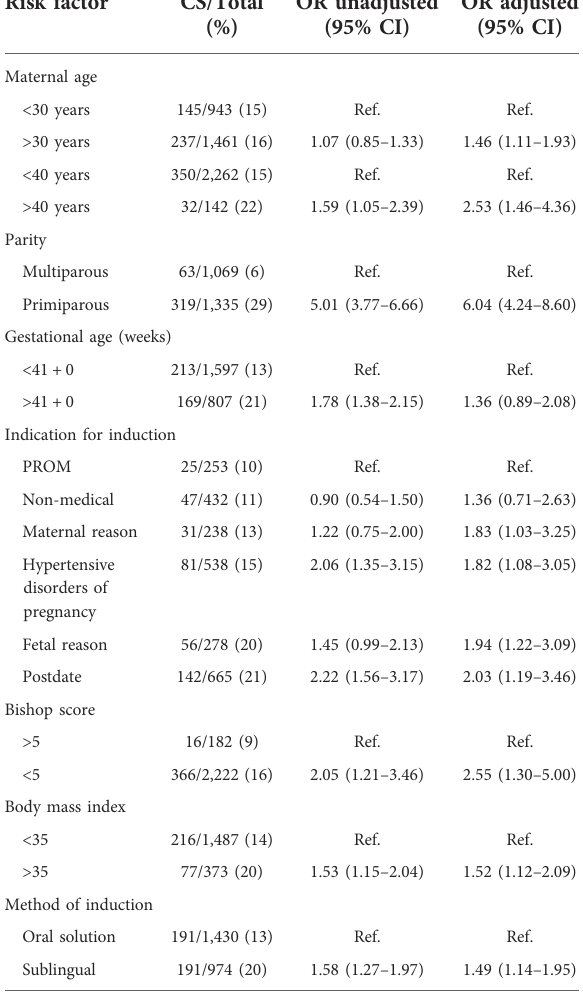
TABLE 3 Odds ratio for cesarean delivery adjusted for various risk